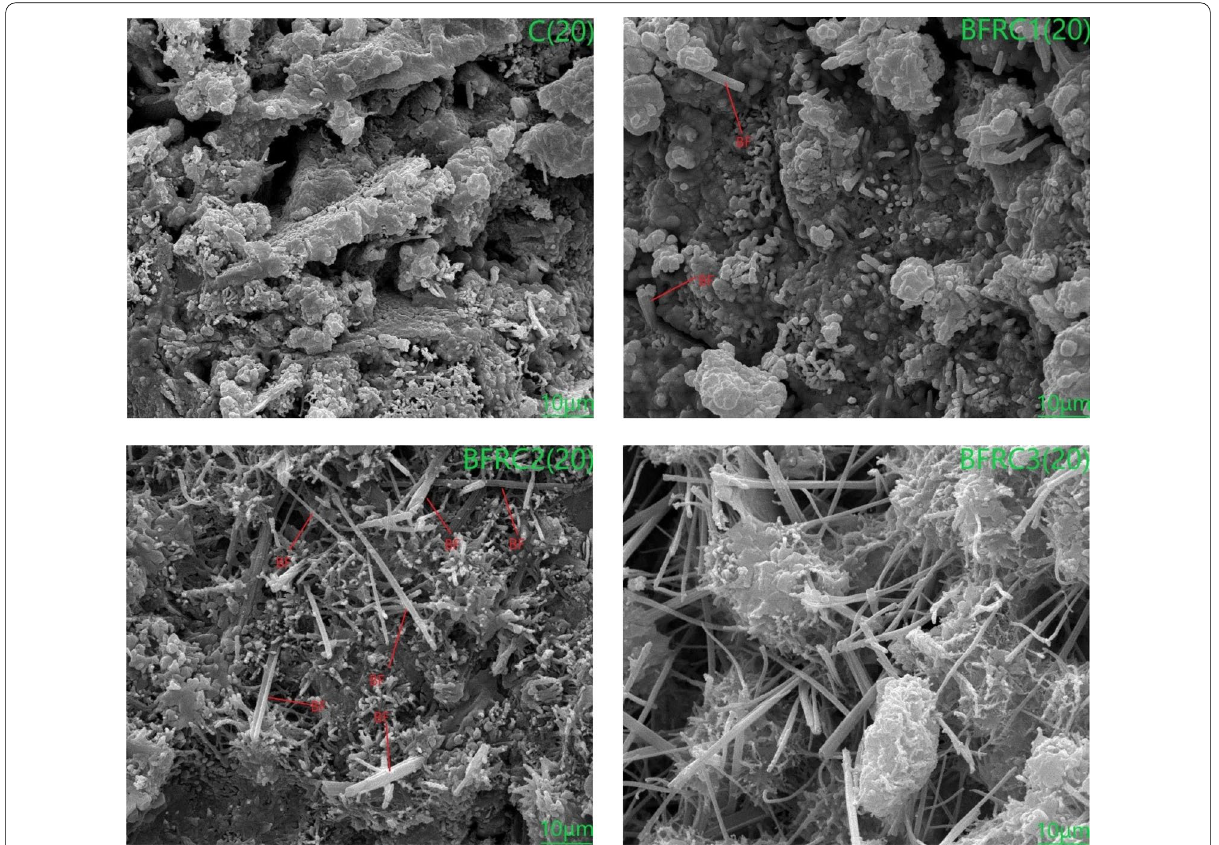
Fig. 9 The SEM of concrete subjected to 20 times of single-side salt-freezing–drying–wetting